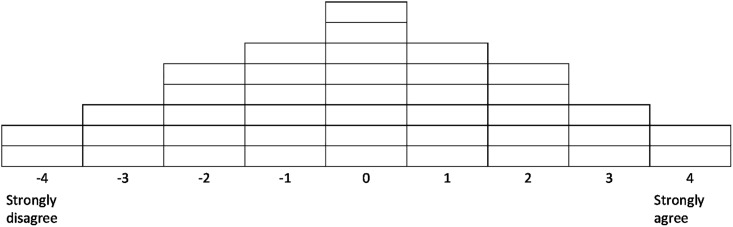
The Q-sorting grid.